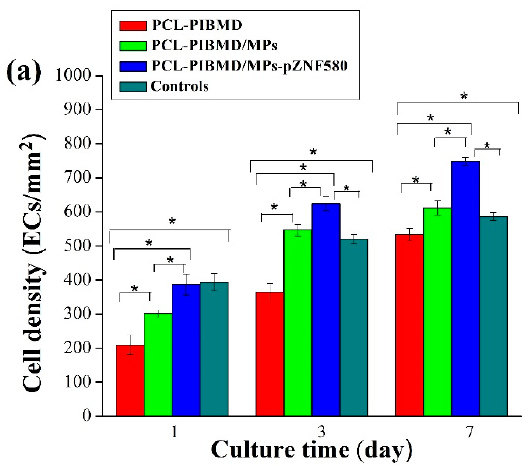
Figure 4. Cont . Figure 4.